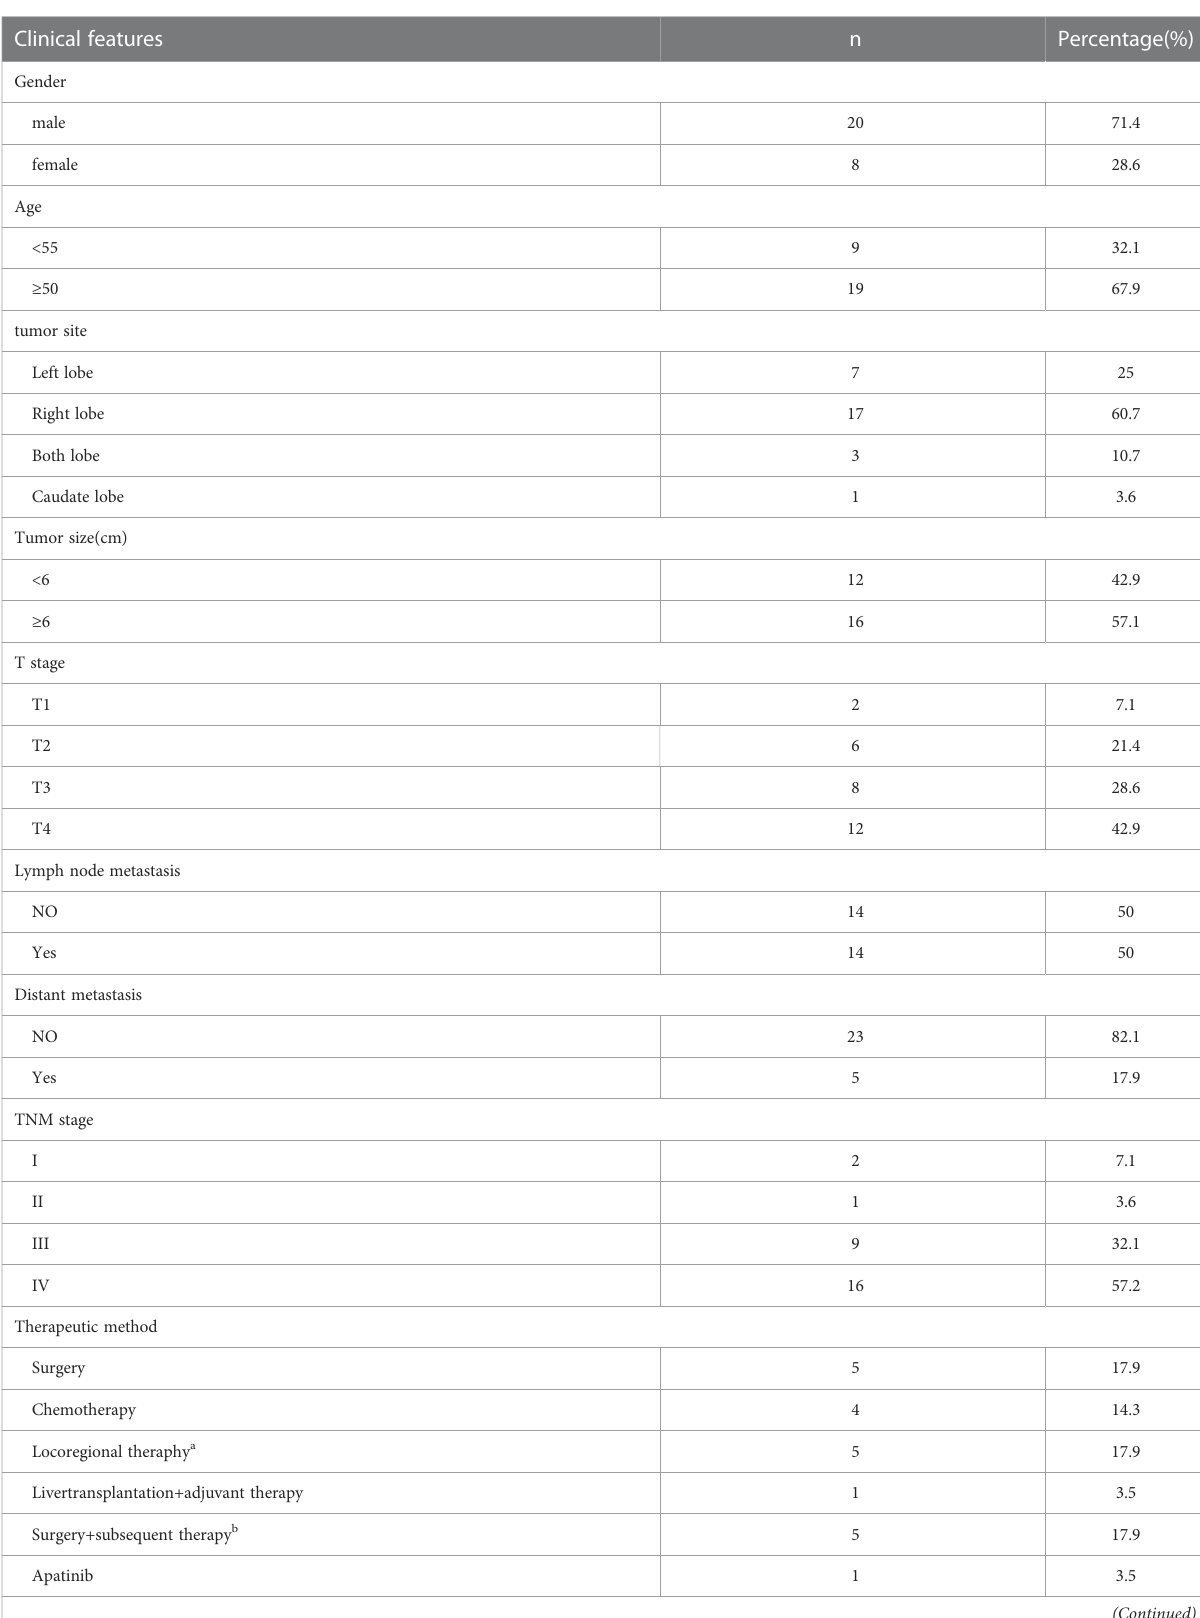
TABLE 1 Clinical features of 28 sarcomatoid hepatocellular carcinoma patients. Clinical